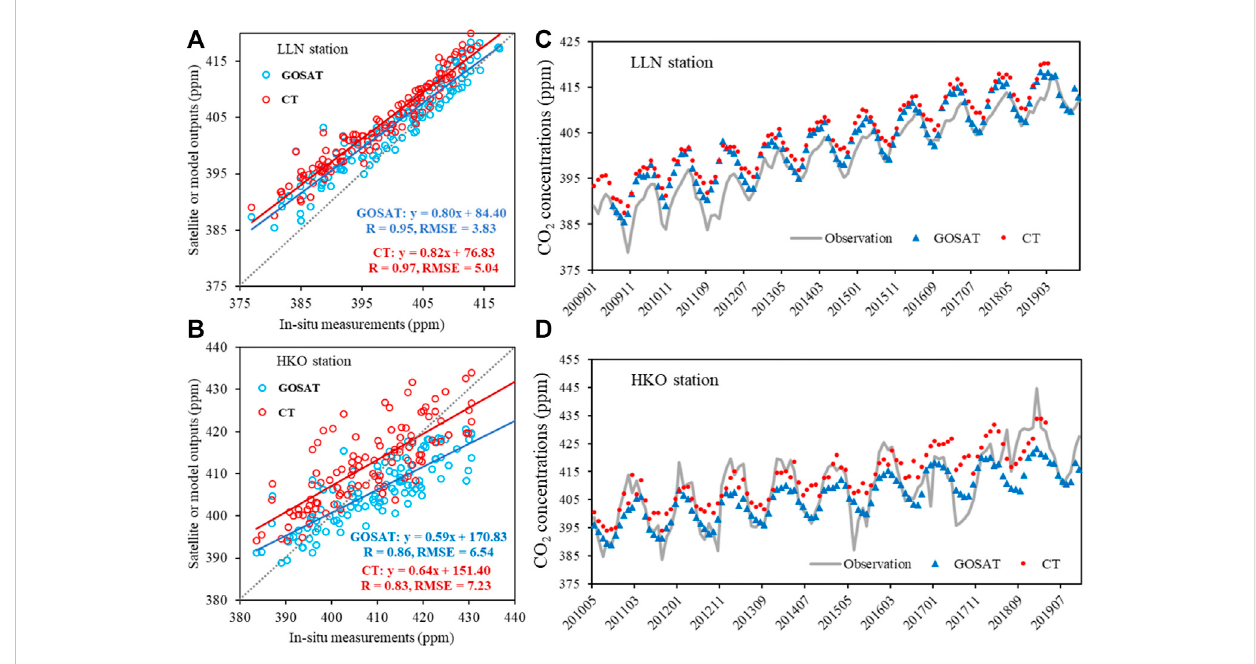
FIGURE 2 Scatterplots (A, B) and the comparison of time series (C, D) between in situ measurements and GOSAT and